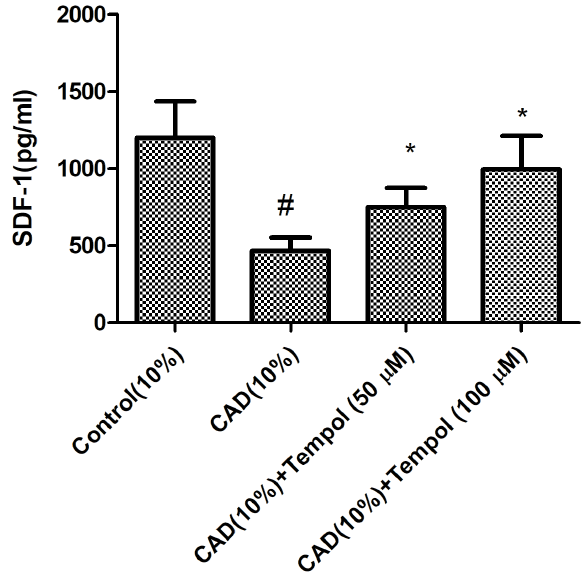
Figure 5: Effects of CAD serum on SDF-1 levels. *p<0.05 vs. Control